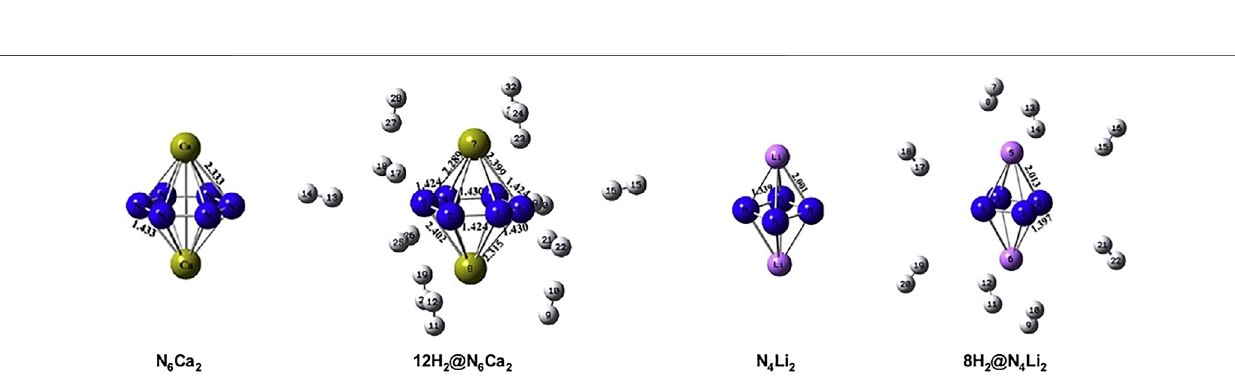
Frontiers in Energy Research |